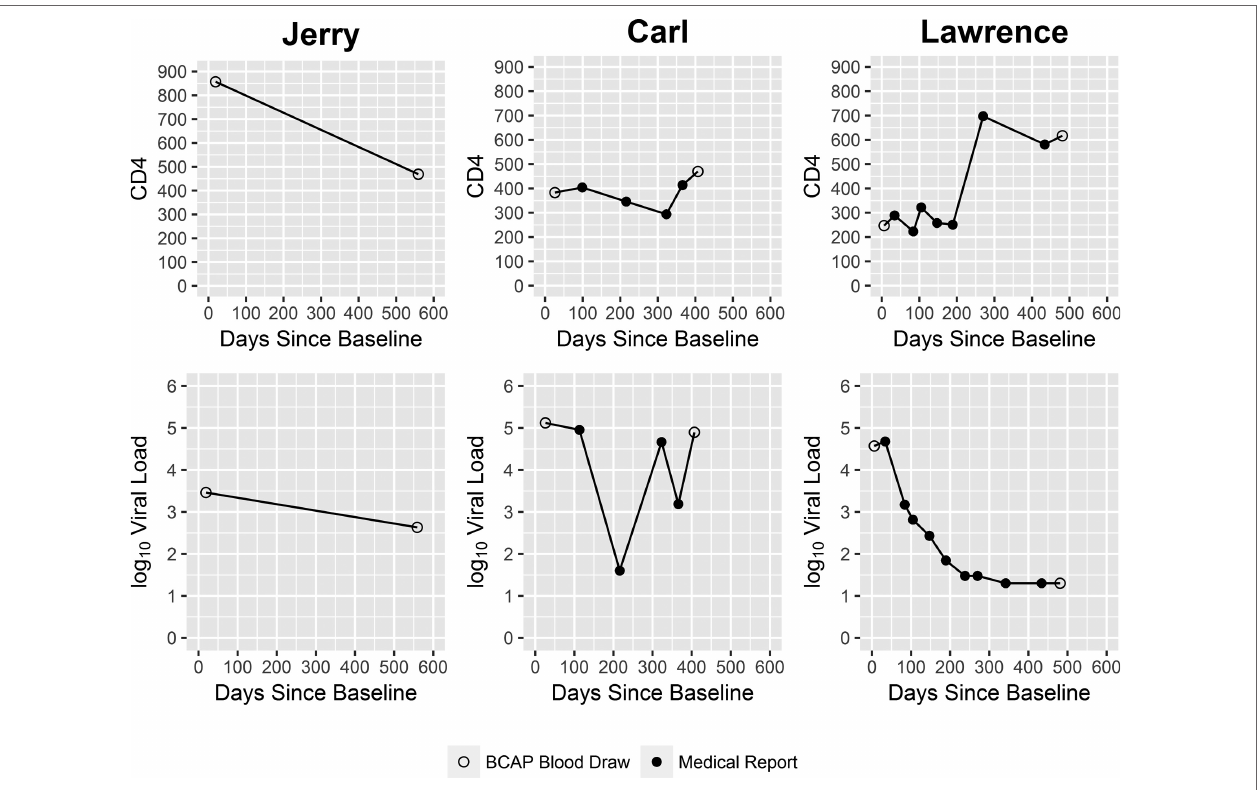
FigUre 2 | clinical outcomes for case study participants